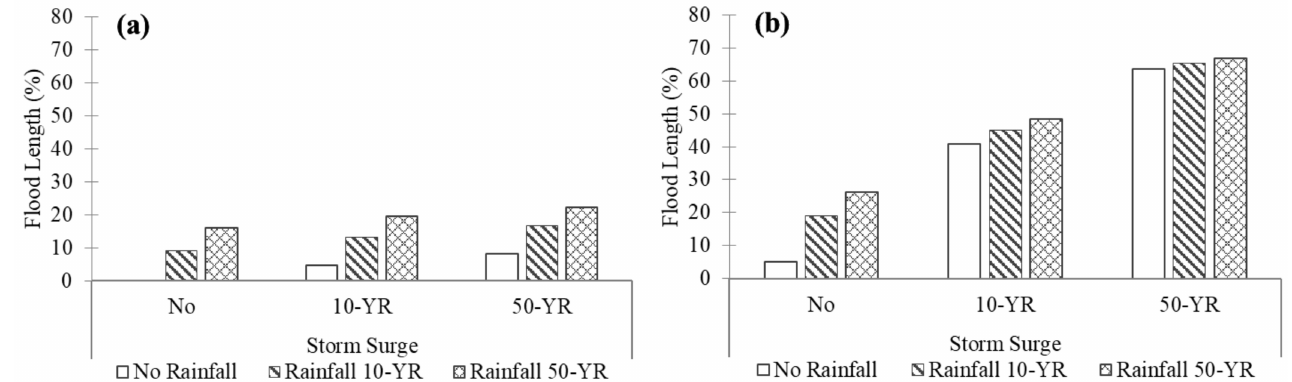
Figure 14. Percentage of flooded road length under the tested storm scenarios: ( a ) 2020 conditions and ( b ) 2070 conditions under high SLR and RCP8.5